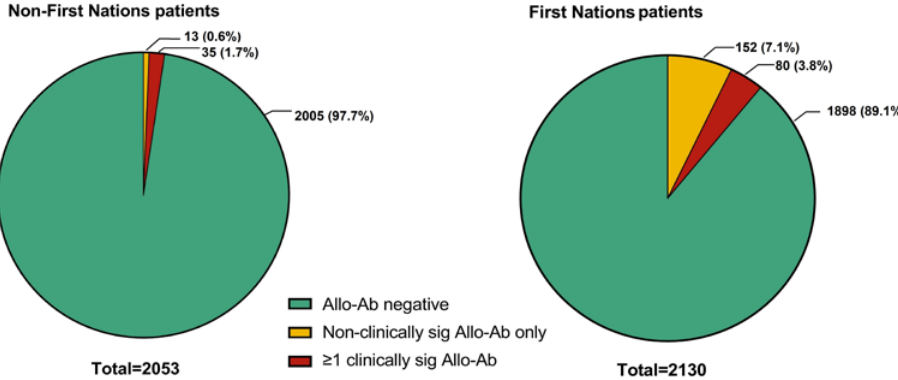
Figure 2. Period prevalence of patients with one or more clinically significant (sig) alloantibodies (Allo-Ab) versus non-clinically significant alloantibodies alone, grouped by First Nations status.